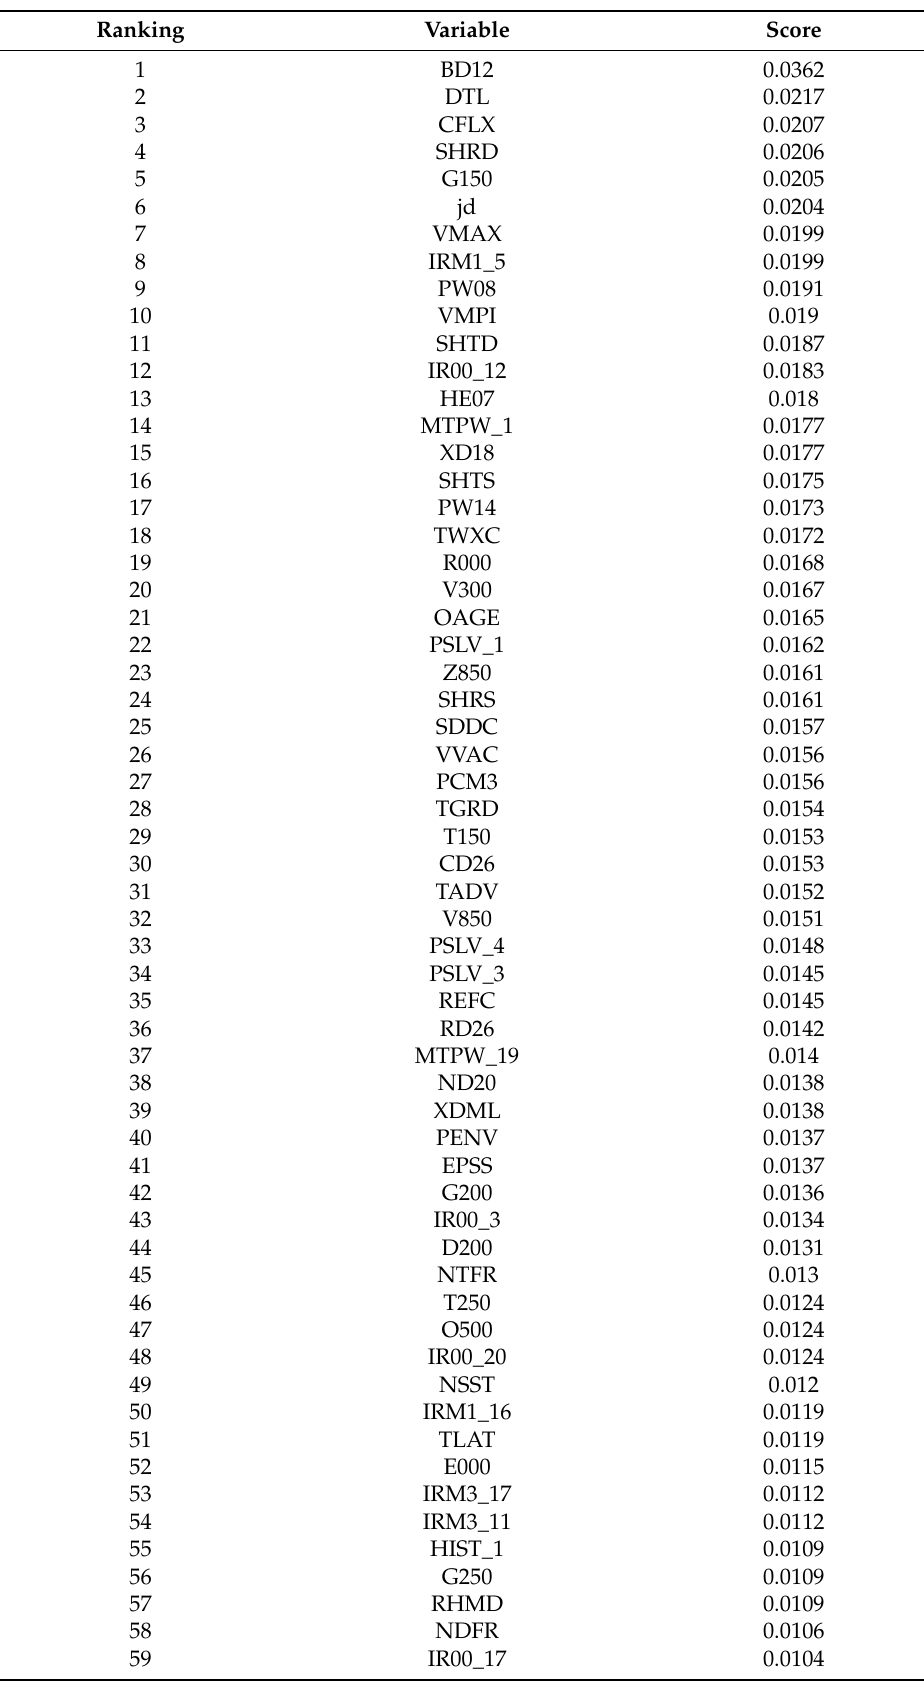
Table A2. The full variable important list including rankings, variable names, and the importance